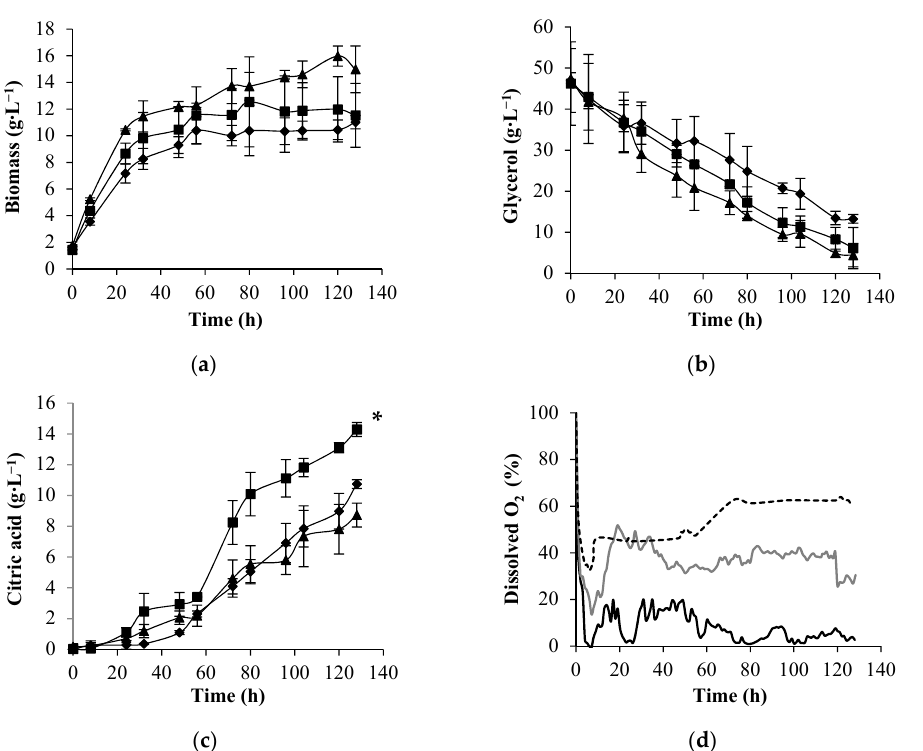
Figure 3. Biomass concentration ( a ), glycerol consumption ( b ), citric acid production ( c ), and dis- solved oxygen concentration profiles ( d ) obtained in batch cultures of Y. lipolytica W29 in an airlift bioreactor at 1 vvm ( ♦ , black line), 1.5 vvm ( ■ , grey line), and 2 vvm ( ▲ , dashed line). The error bars represent the standard deviation of two independent replicates. * Statistically different ( p < 0.05).